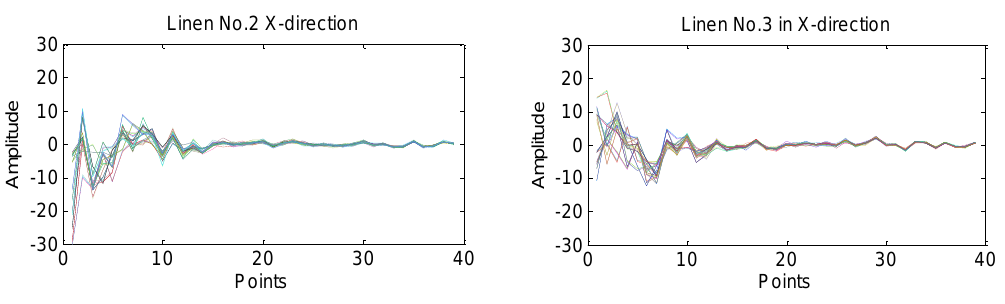
Figure 9. The dimension reduction results of linen No.2 and linen No.3.